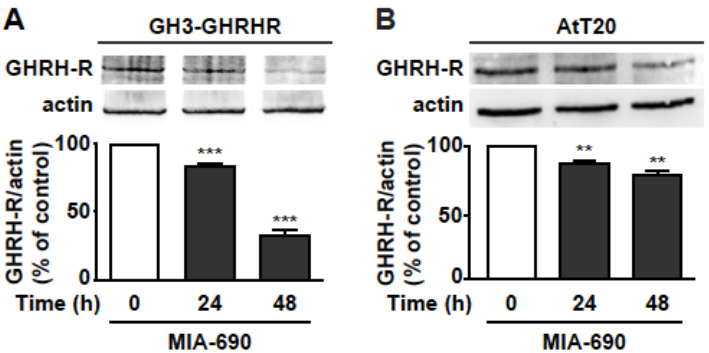
Figure 5. MIA-690-induced downregulation of GHRH-R in GH3-GHRHR and AtT20 cells. Representative Western blot for GHRH-R expression in GH3-GHRHR ( A ) and AtT20 cells ( B ) treated for 24 h and 48 h with 1 µm MIA-690. Equal protein loading was determined by re-probing with antibodies to actin (bottom panels). Results, normalized to actin and expressed as percent of control (Time 0), are means ± SEM. ** p < 0.01, *** p < 0.001 vs. control by unpaired Student ’ s t -test ( n = 3).